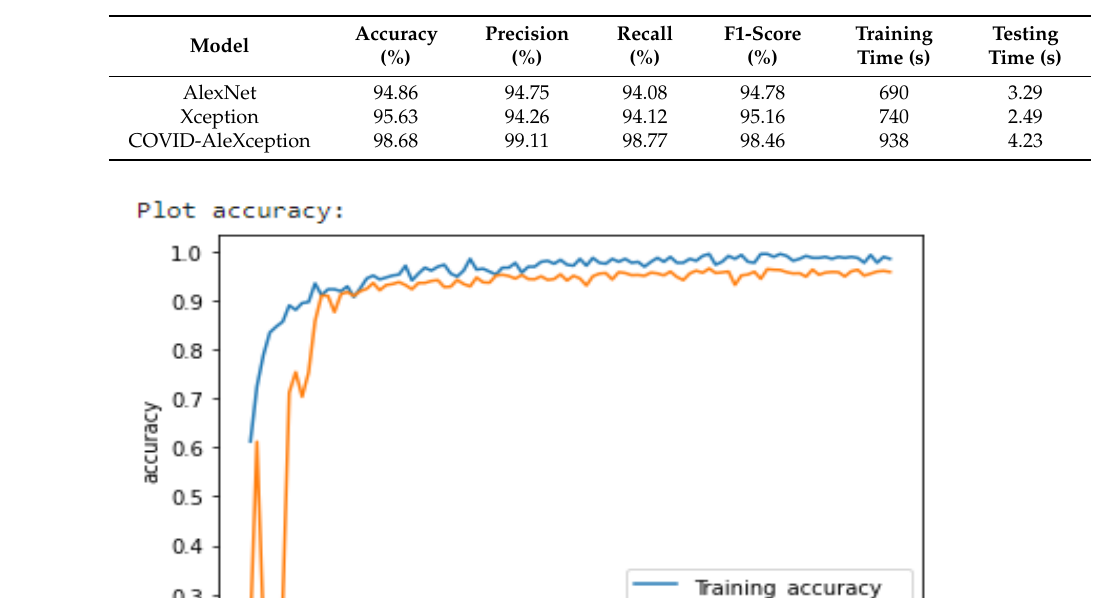
Table 4. Average classification results for the classification task of the original dataset.